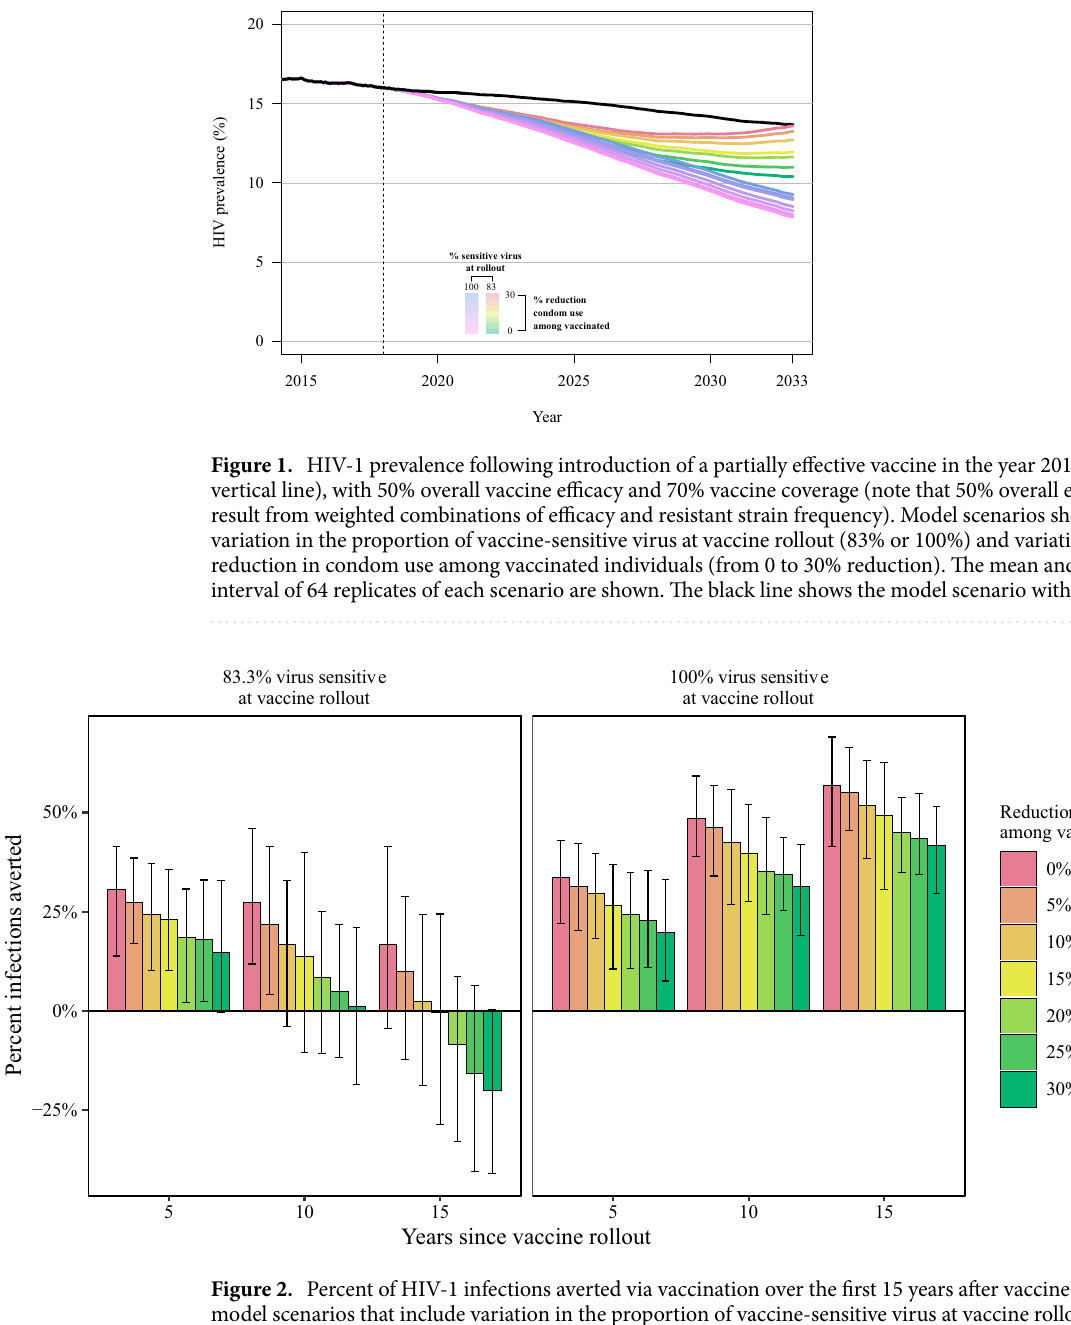
Figure 2. Percent of HIV-1 infections averted via vaccination over the first 15 years after vaccine rollout, in model scenarios that include variation in the proportion of vaccine-sensitive virus at vaccine rollout (83% or 100%) and variation in the reduction in condom use among vaccinated individuals (from 0 to 30% reduction), with 50% overall vaccine efficacy and 70% vaccine